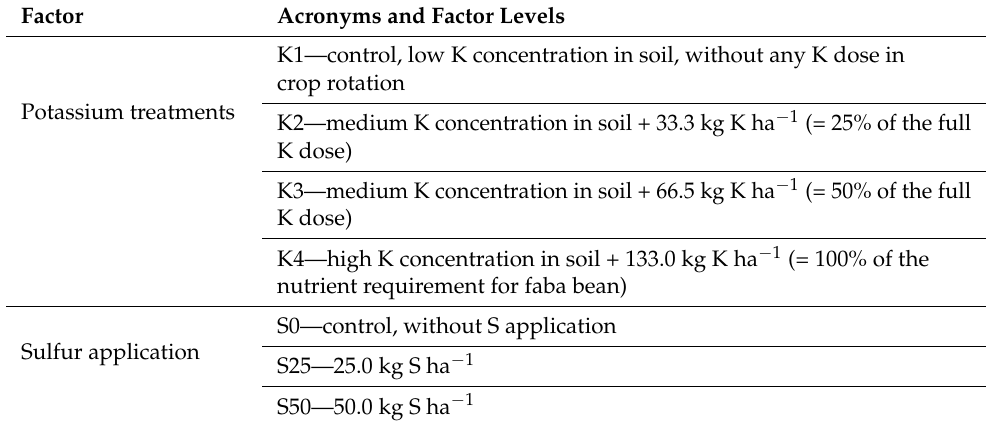
Table 1. Experimental factors and their